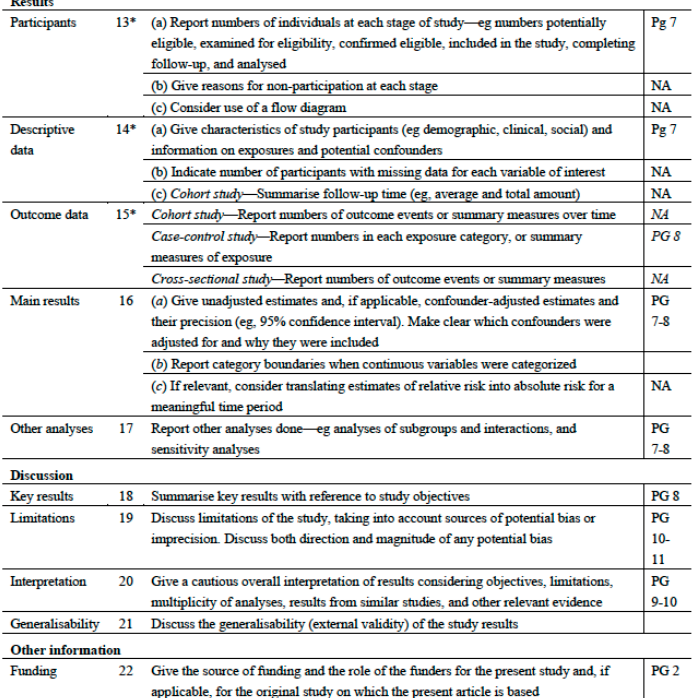
CPITN index: Community Periodontal Index was measured for assessment of per- iodontal status, by using a mouth mirror and a CPITN probe which was a specifically designed periodontal probe with a 0.5 mm ball tip and a black band between 3.5 and 5.5 mm and with rings at 8.5 and 11.5 mm from the ball tip. According to WHO protocol [ 13 ], the dentition was divided into 6 sextants which are defined by tooth numbers: 14–18, 13– 23, 24–28, 38–34, 33–43, and 44–48, and it was coded as following: Code 0- healthy peri- odontium, Code 1—bleeding on gentle probing, Code 2—calculus deposits being felt on probing, Code 3—pocket 4–5 mm (black band on the probe partially visible), Code 4—pocket 6mm or more (black band on probe not visible) and Code x—excluded (less than two teeth present). The index teeth which have to be examined are 17, 16, 11, 26, 27, 37, 36, 31, 46, and 47. If no index teeth are present, all the remaining teeth in that sextant are examined and the highest score is recorded as the score for the